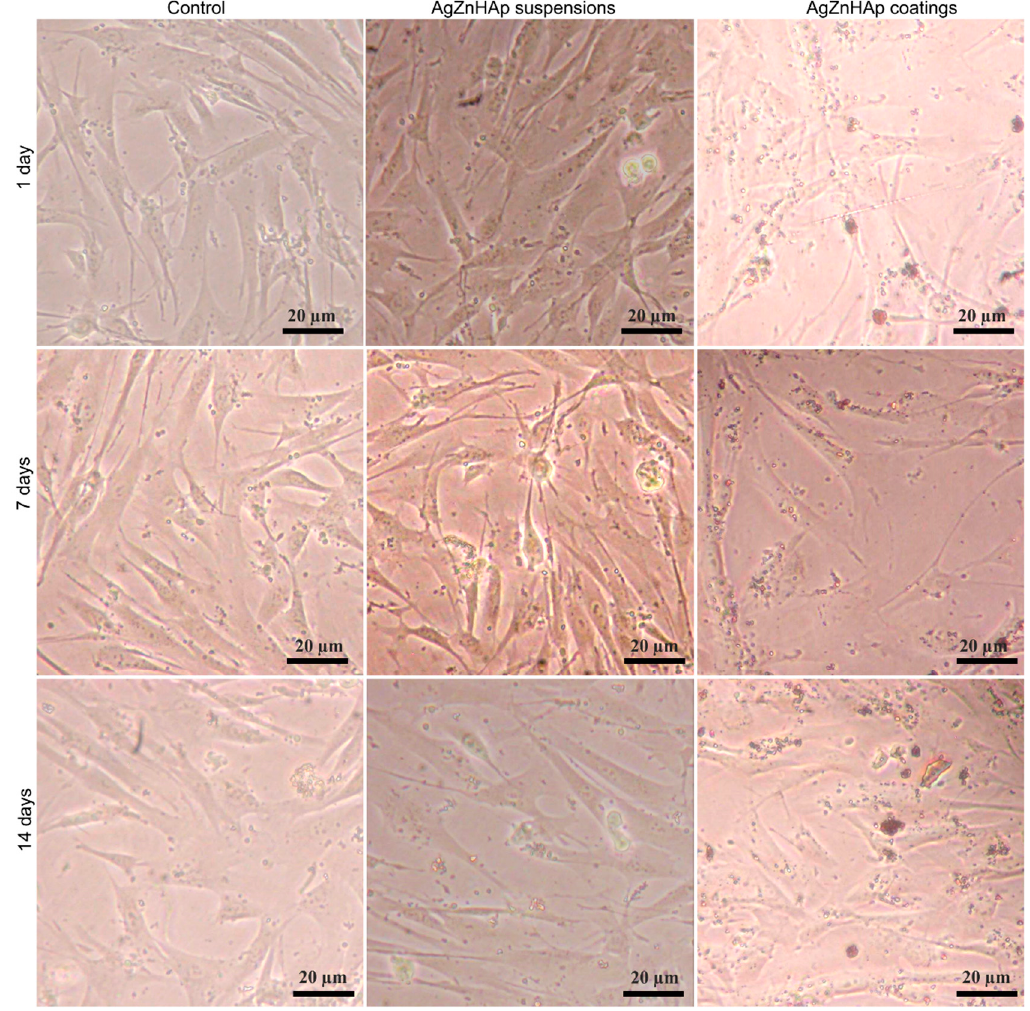
Figure 9. The morphology of the hFOB 1.19 cells incubated with AgZnHApCs suspensions and coatings after 1, 7 and 14 days.